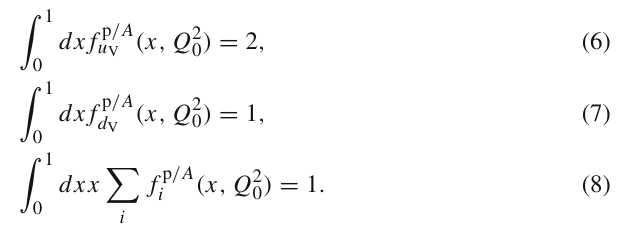
x = x a , x = x e and x = 0. The parametrization is illustrated in Fig. 1, where the variation induced by the parameter a 2 is also